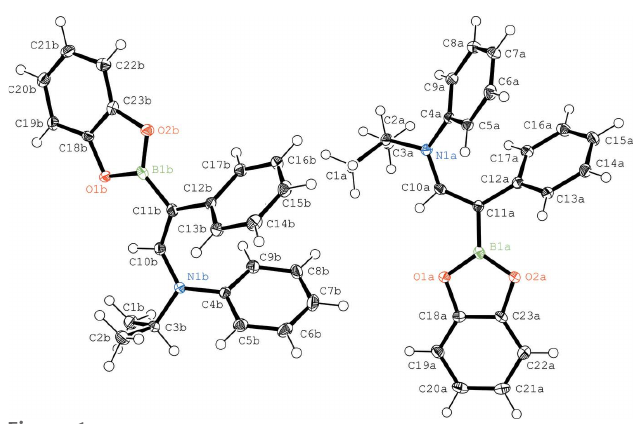
Figure 1 The molecular structures of the two independent molecules of the title compound 1 with displacement ellipsoids drawn at the 50% probability level.